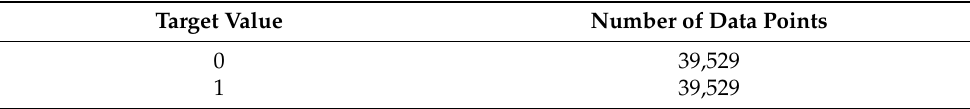
Table 6. Target values after SMOTE.